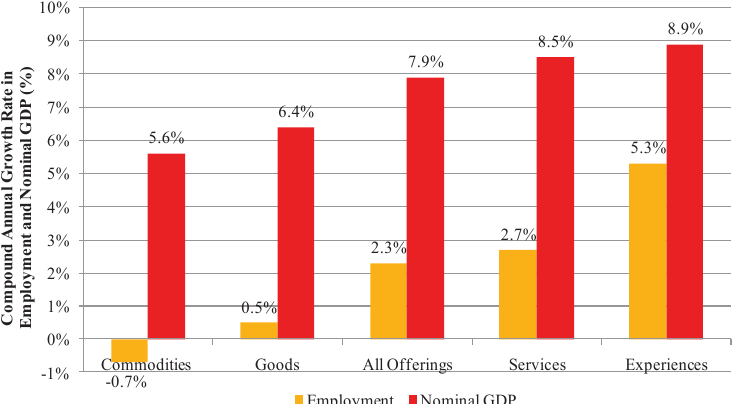
Figure 3. Annual growth in employment and nominal gross domestic product (GDP) per economic offering (%,